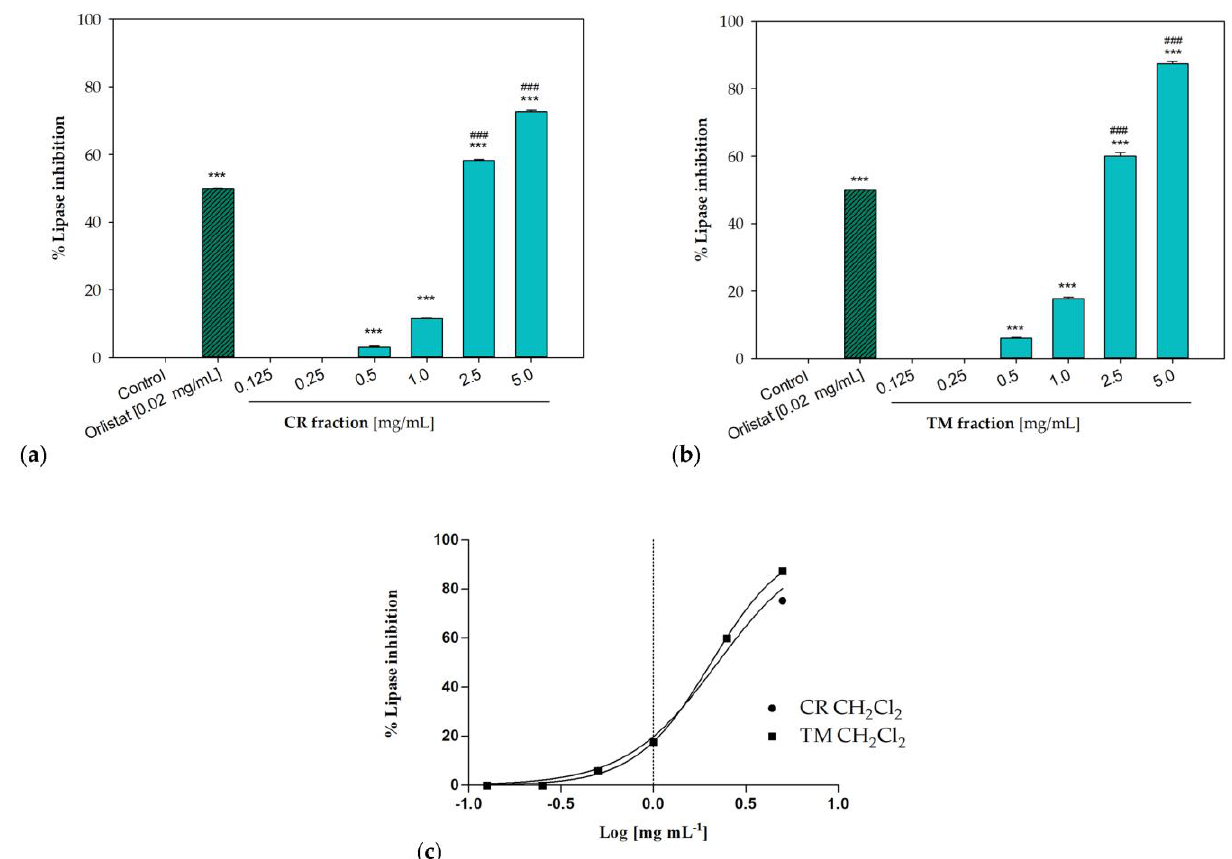
Figure 6. Pancreatic lipase inhibition induced by the dichloromethane fractions of ( a ) C. ruber (L.) DC. and ( b ) T. majus L. raw extract. ( c ) Non-linear regression curves. Data were expressed as mean ± S.E.M. (n = 3). Orlistat (0.02 mg/mL) was used as a positive control. CR: C. ruber (L.) DC.; TM: T. majus L. Significant difference versus control: *** p < 0.001; significant difference versus positive control: ### p < 0.001 (Dunnett ’ s multiple comparison test).